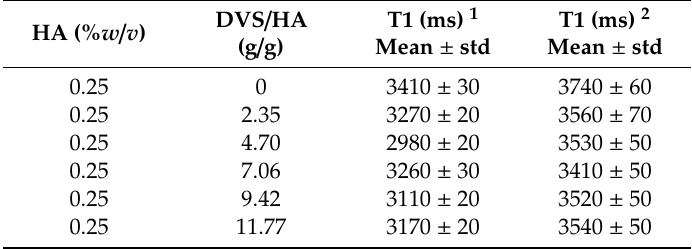
Table 1. Longitudinal relaxation time (T1) at di ff erent DVS / HA mass ratio. DVS / HA (% w / v )